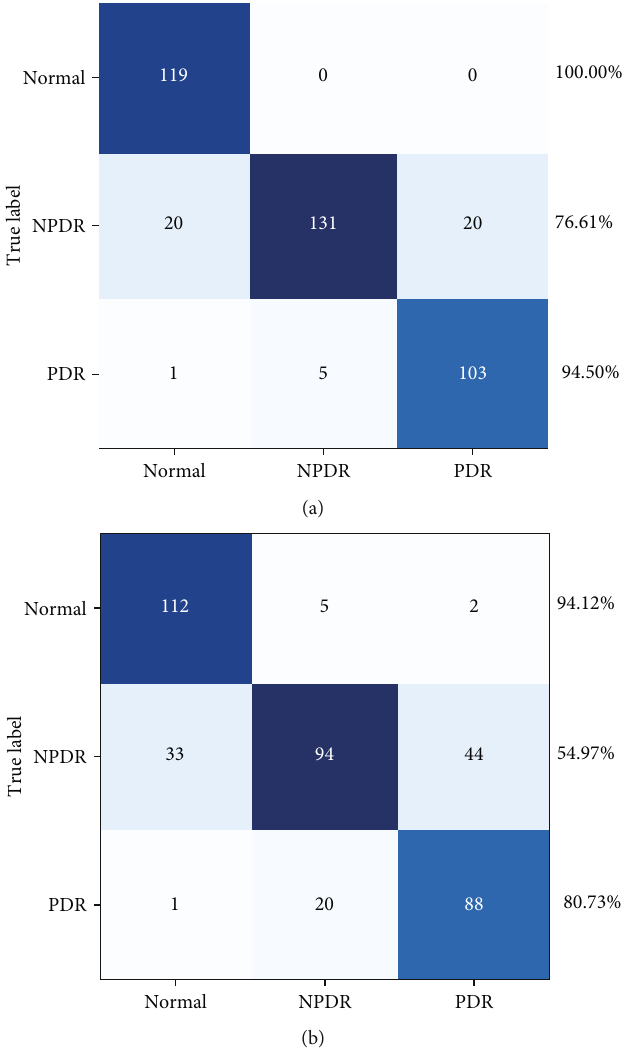
Figure 4: The confusion matrix of the classi fi cation results. The classi fi cation results of the original UWFA images achieved 100.00% accuracy for normal eyes, 94.50% for PDR, and 76.61% for NPDR, respectively. The classi fi cation results of the 7-SF images achieved 94.12% accuracy for normal eyes, 80.73% for PDR, and 54.97% for NPDR,